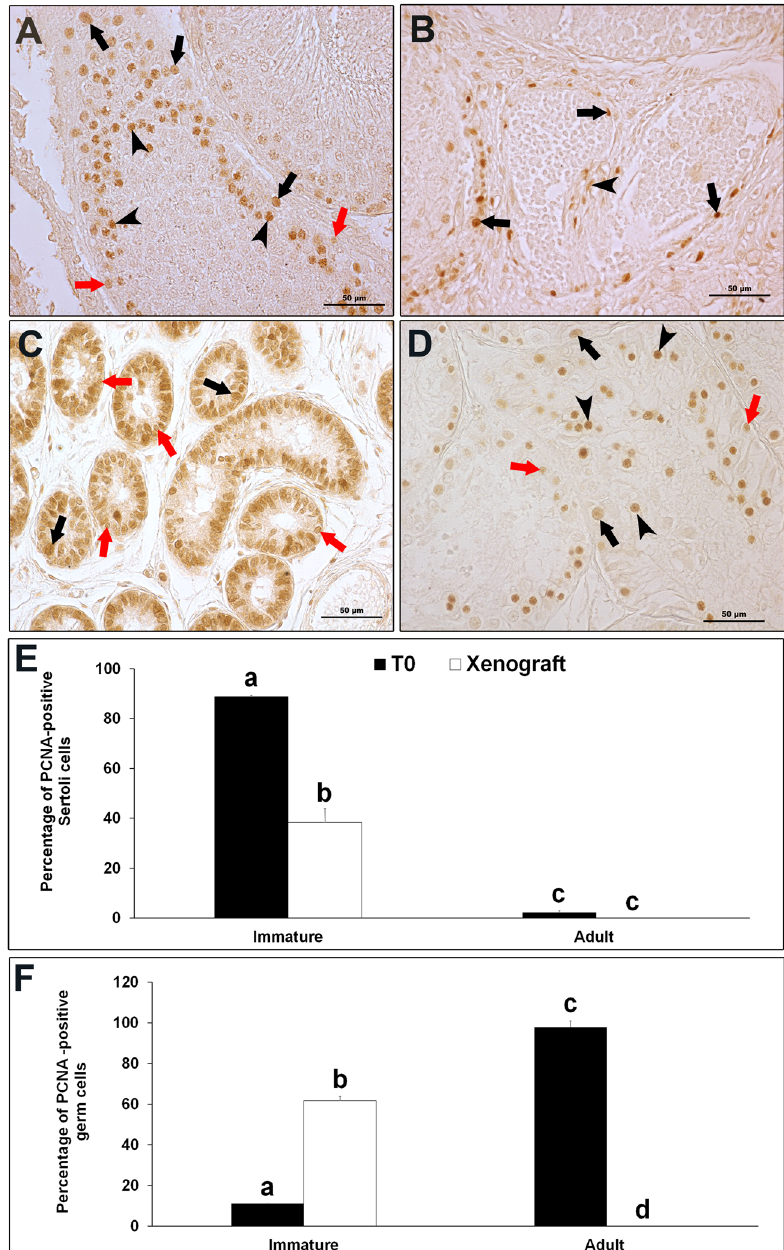
Figure 2. Proliferating cell nuclear antigen (PCNA) immunostaining ( A ) In donor tissue from 10-wk-old rat (T0). Black arrows indicate PCNA-positive spermatogonia, red arrows indicate PCNA-positive Sertoli cells and, arrow heads indicate PCNA-positive spermatocytes. ( B ) In adult rat testis xenograft at 8-wk-post grafting. Note that no PCNA-stained cells are present inside the seminiferous tubules. Although, PCNA-stained cells in the peri-tubular region (arrows) and in interstitial space (arrow head) were observed. Expression of PCNA protein in ( C ) In immature donor tissue from 6-day-old rat (T0) and, ( D ) Immature rat testis xenograft at 8-wk -post grafting. Black arrows indicate PCNA-positive spermatogonia, red arrows indicate PCNA-positive Sertoli cells. In ( D ), arrow heads indicate PCNA-positive spermatocytes. ( E ) Percentage of PCNA- positive Sertoli cells and ( F ) Percentage of PCNA- positive germ cells in donor and grafted testes. Data are presented as mean ± SEM. Bars with different letters are significantly different at P < 0.05. Scale bar = 50 µ